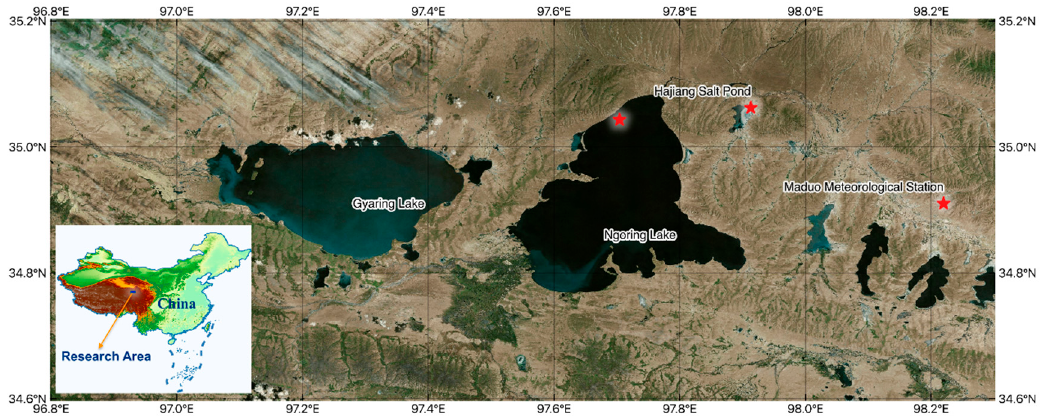
Figure 1. Map of the research area, locations of the Ngoring Lake (NL) and Hajiang Salt Pond (HSP), and three observation sites (marked by red